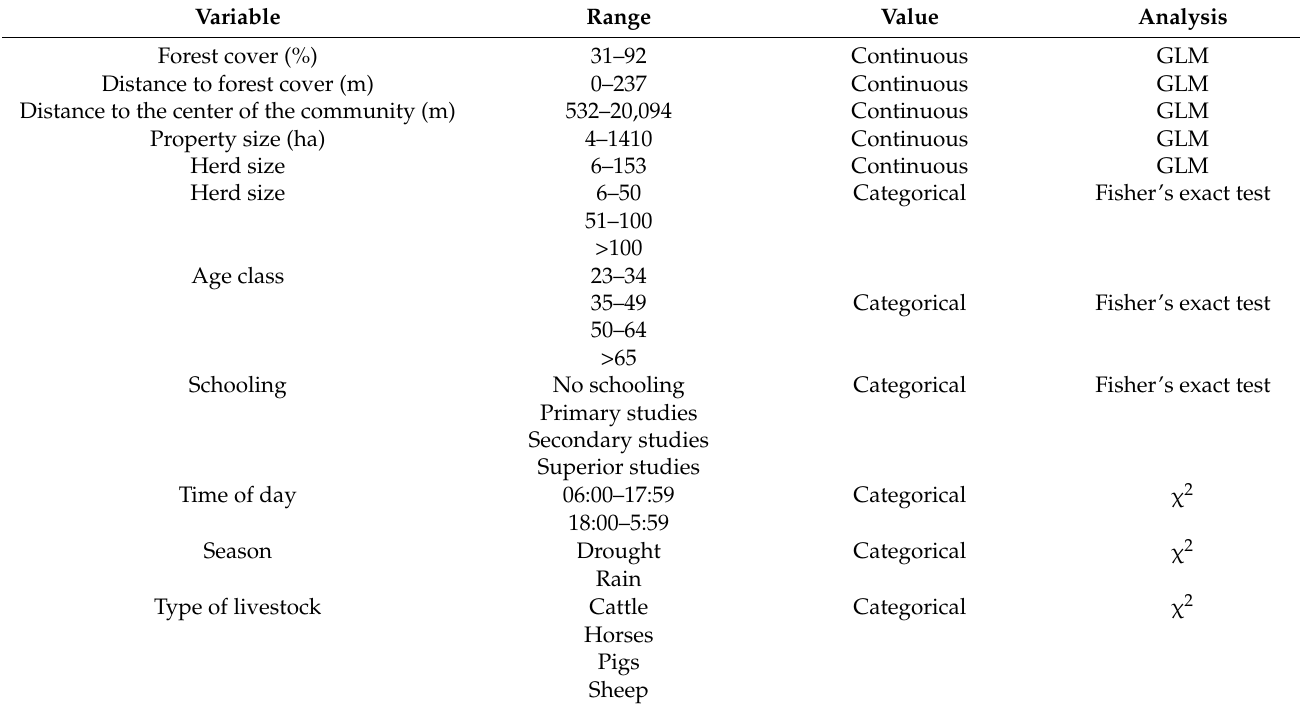
Table 1. Description of the variables selected for